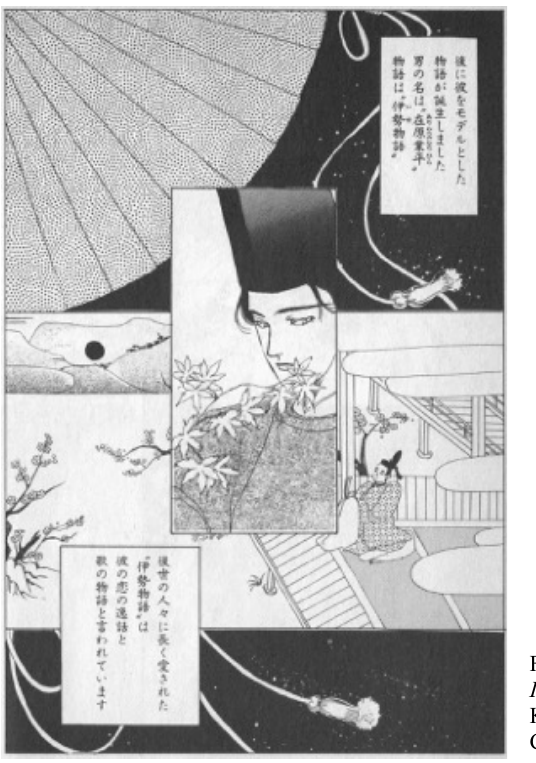
Figure 4. Hosomura Makoto, Ise monogatari (Tokyo: Kadokawa shoten, 1993), 8. Courtesy of Kadokawa